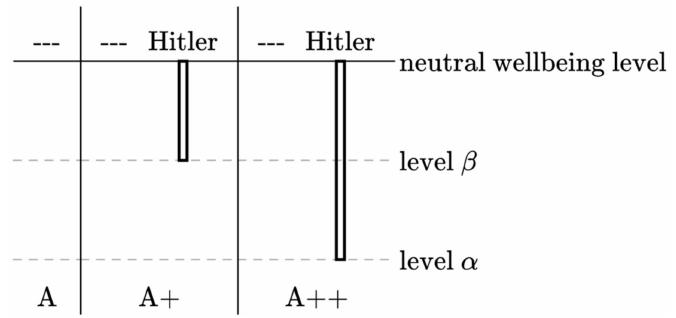
Figure 3. The desert-neutrality